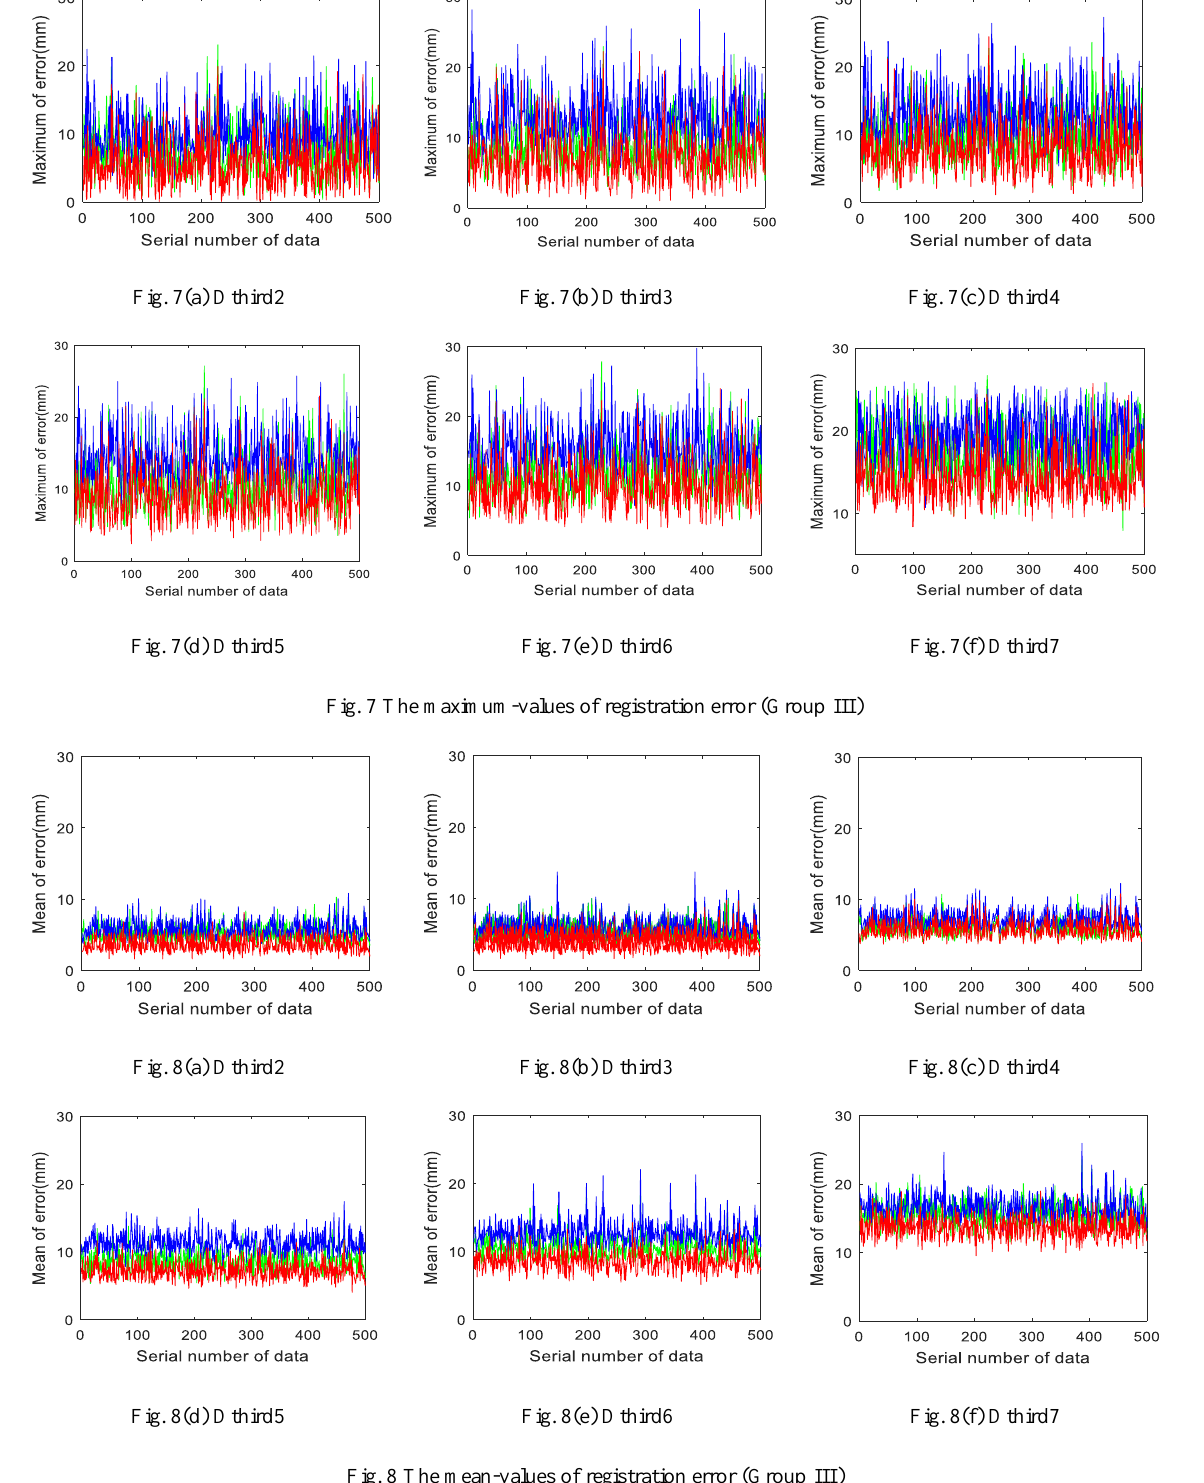
Fig. 8 The mean-values of registration error (Group